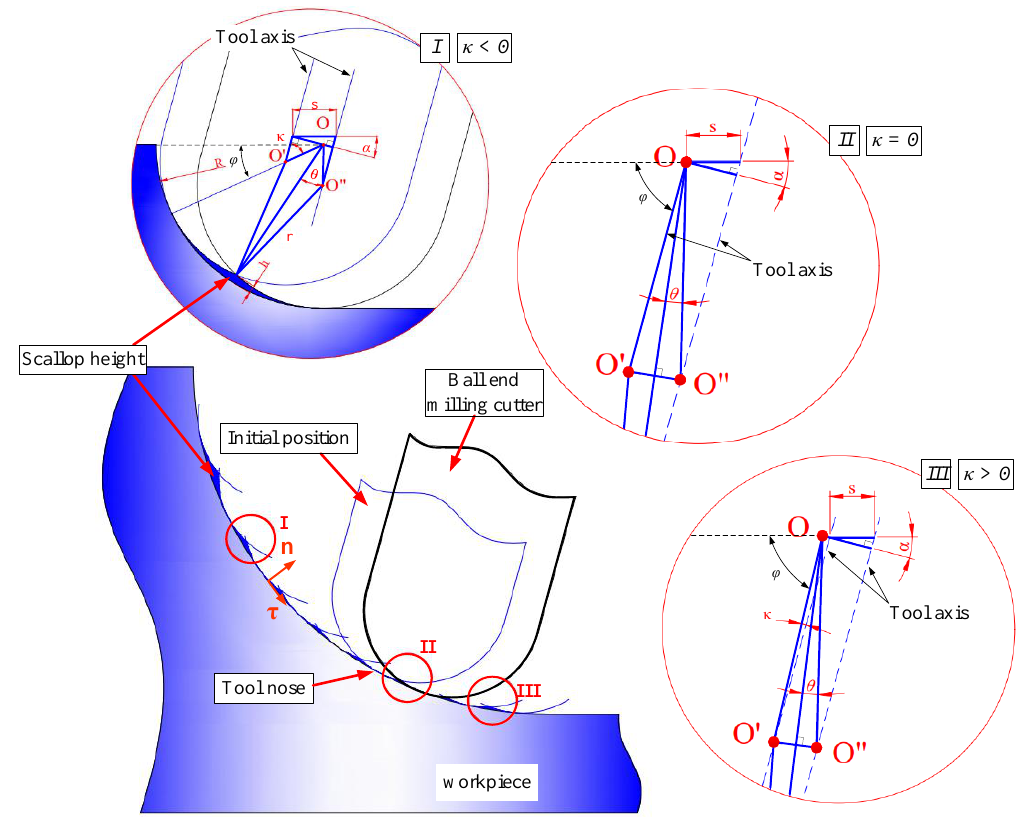
Figure 6. Scallop heights at different locations for micro-fillet machining.